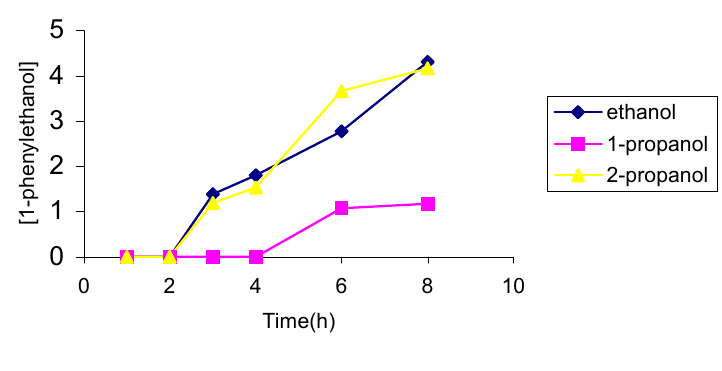
Figure 5. Variation of [1-phenylethanol] vs. time for experiments 8, 9 and 10.